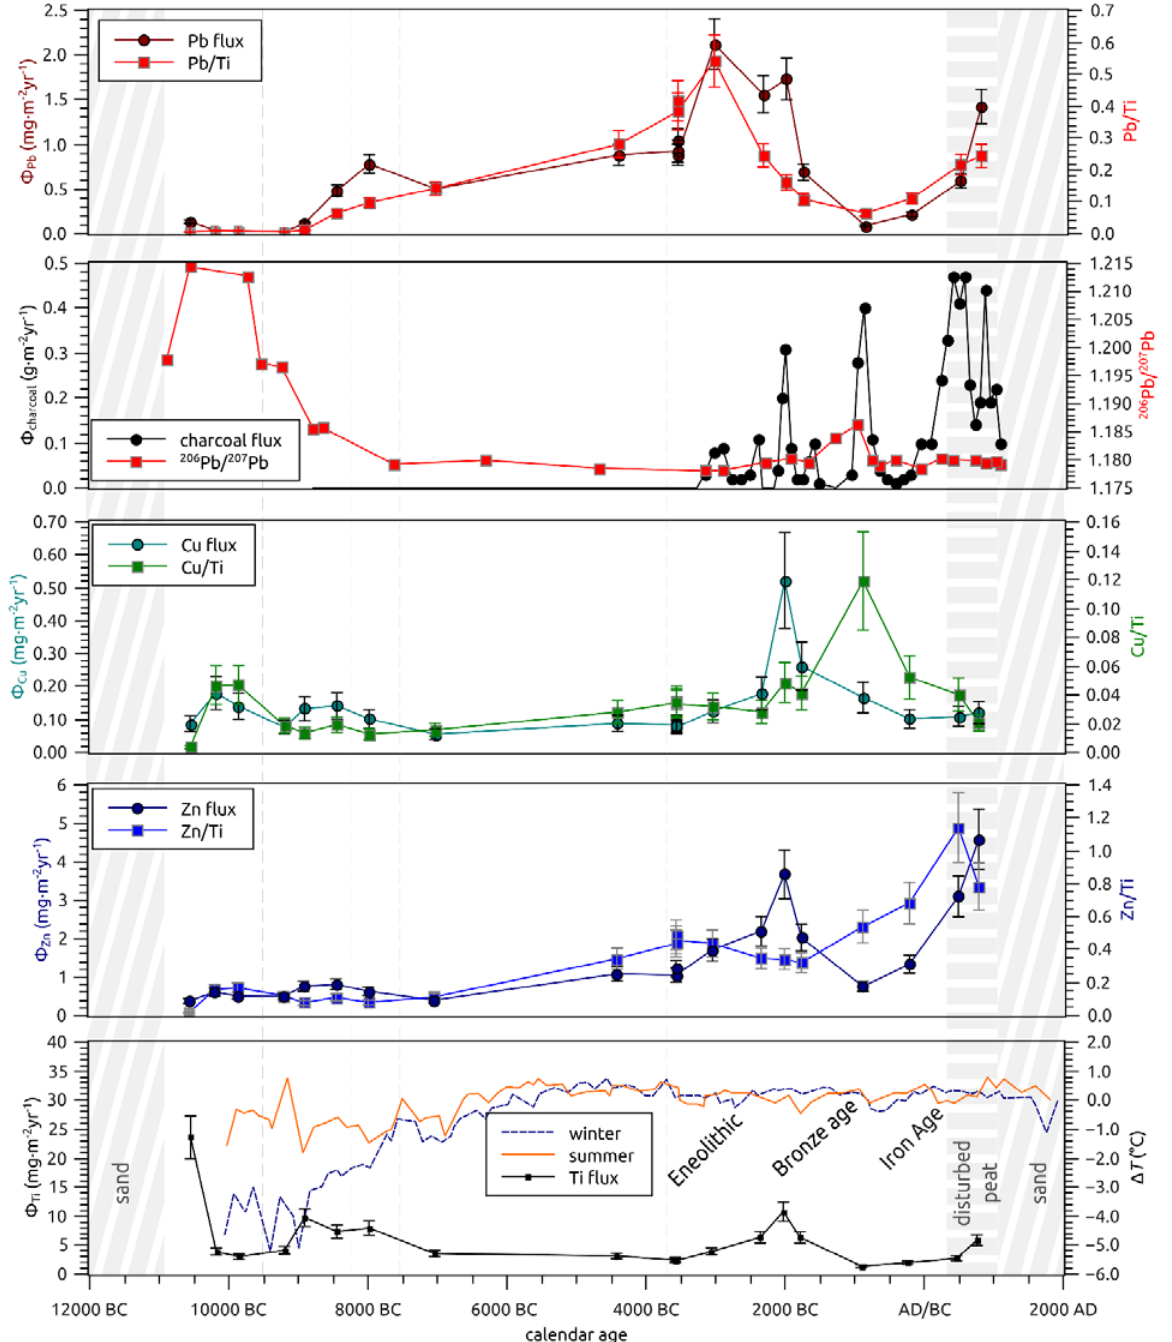
Figure 7. Fluxes of elements and charcoal, lead isotopic quotient, and reconstructed mean summer and winter temperature difference for east-central Europe during the Holocene (Davis et al .